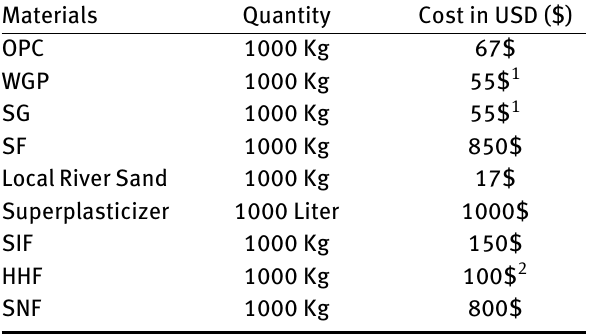
Table 11: Estimated cost of material used